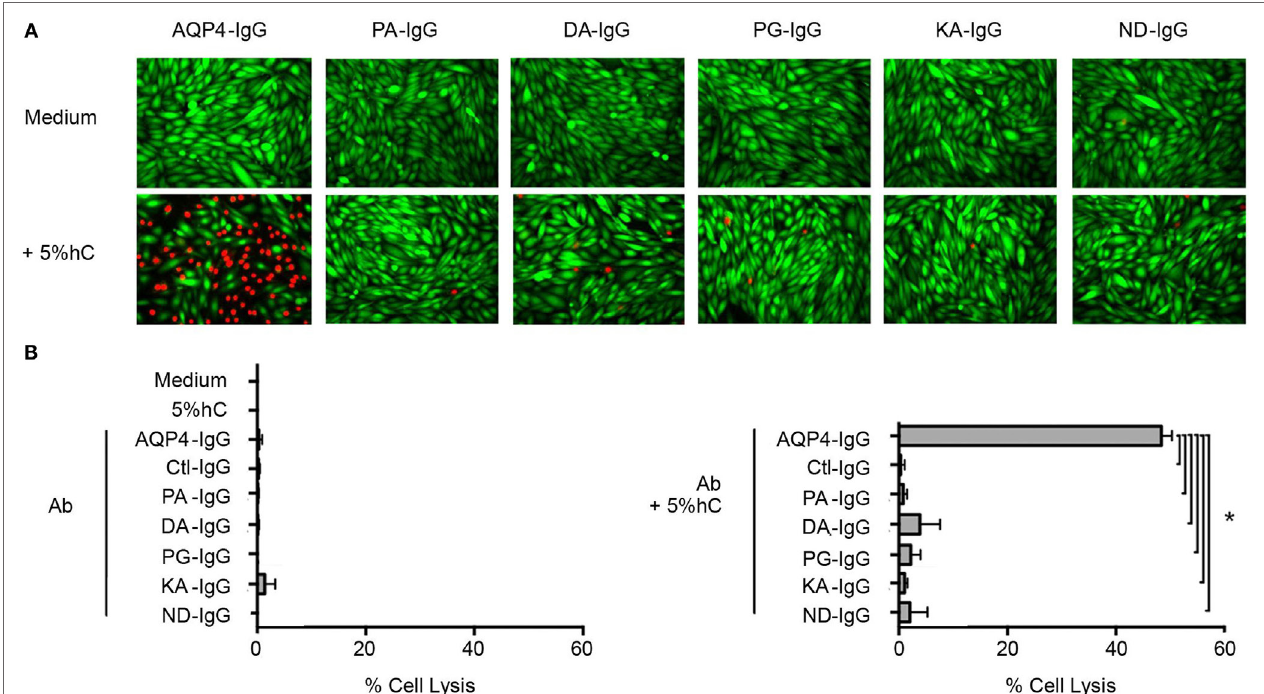
FigUre 2 | Antibody Fc domain mutations limit complement-dependent cytotoxicity activation by AQP4–IgG. (a) CHO cells expressing M23–AQP4 were incubated with 5 µg/ml monoclonal antibody in the absence (left row) or presence (right row) of 5% pooled human serum (hC) for 60 min at 37°C. Live cells are labeled with calcein AM, which is a cell viability dye (green); dead cells are labeled with propidium iodide (red). (B) Cell lysis (mean percentage ± SD) is plotted for medium alone, hC alone, and each monoclonal antibody without (top) or with (bottom) hC. Ctl-IgG is specific for measles virus nucleocapsid protein and serves as a negative control. * p < 0.0001; analysis of variance with Dunnett’s multiple comparisons